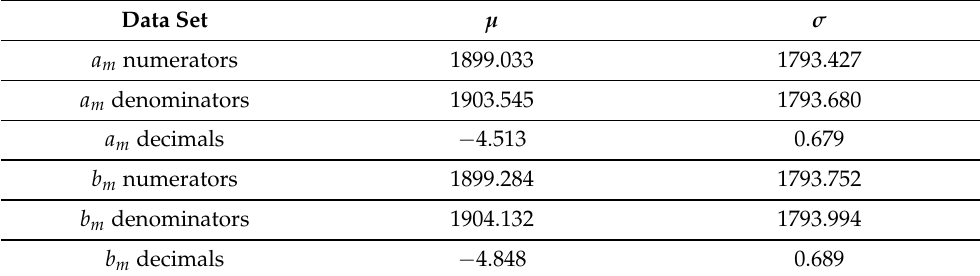
distribution of the data 10